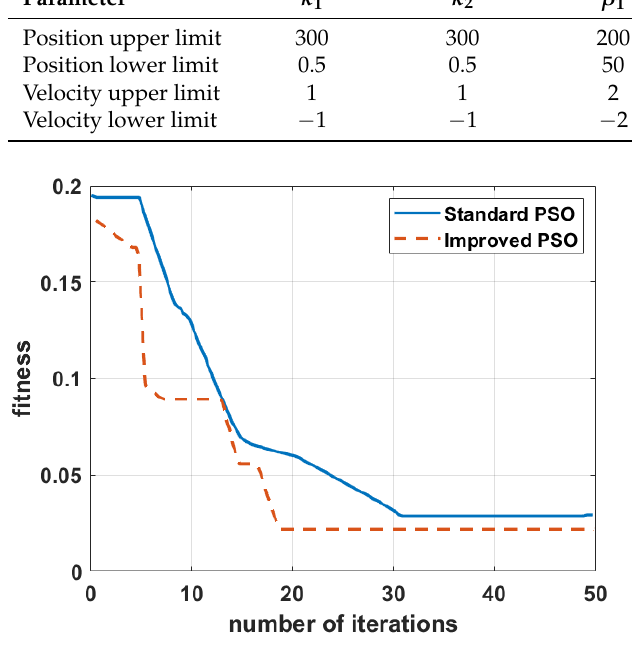
Figure 8. Particle swarm algorithm fitness value change